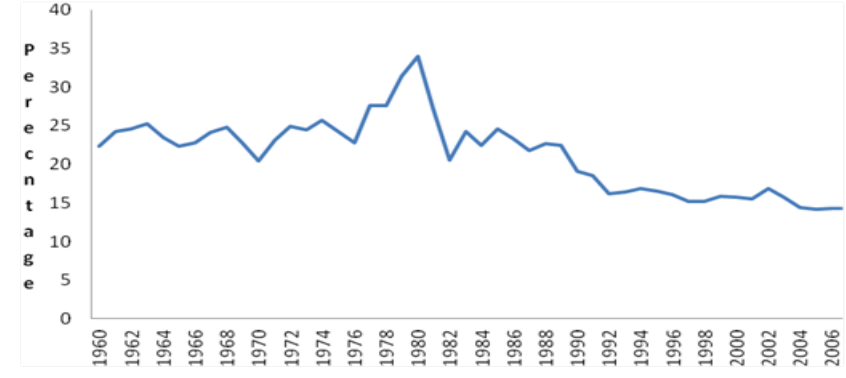
FIGURE 1: Ratio of Gross National Savings to GDP (1960-2007)